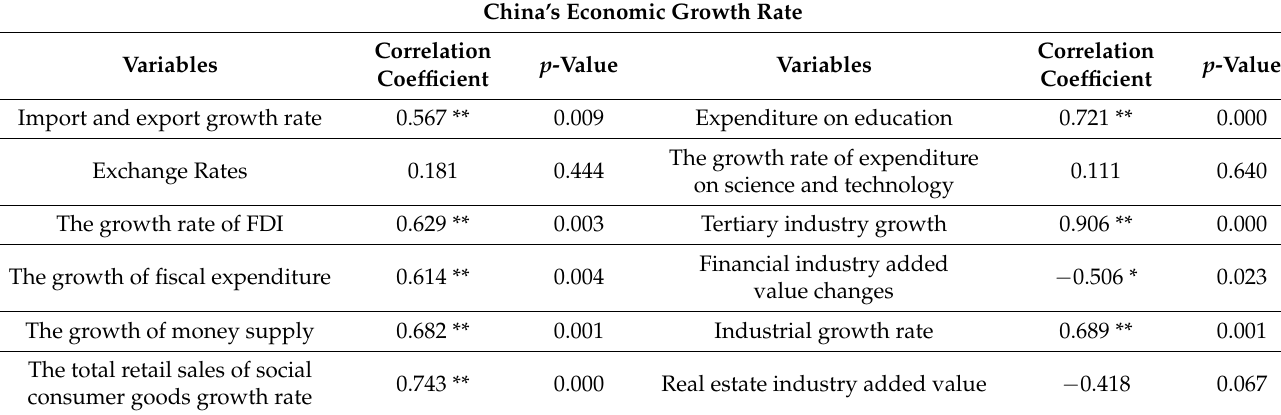
Table 2. Correlation coefficient.